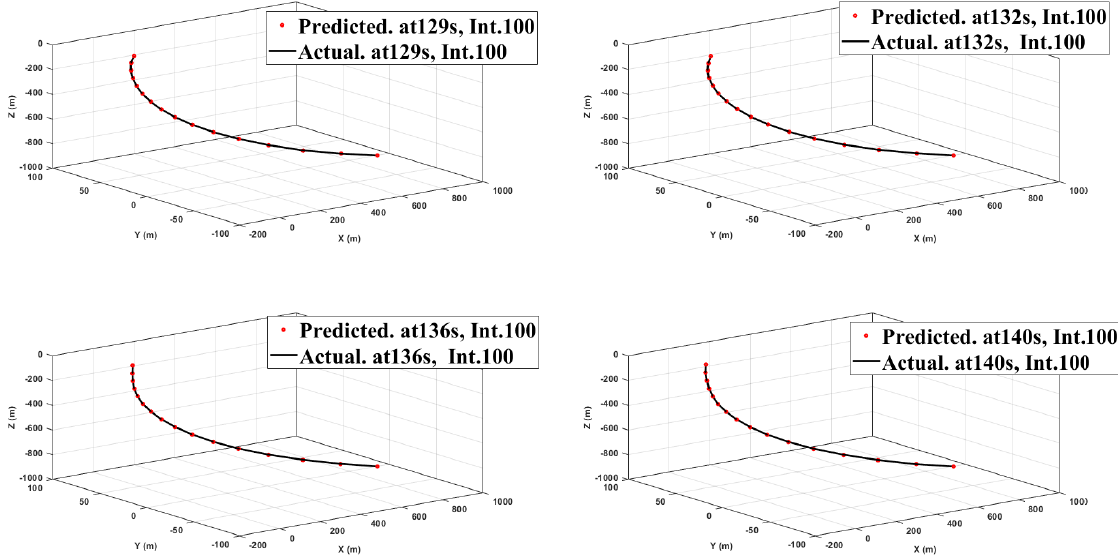
Figure A5. Structural-Health Monitoring Performance Comparison Near Touch Down Zone (= Arc Length 1200–1300 m) and near mid-length (700 m) between DA and FTO Approaches: 100-yr Storm,